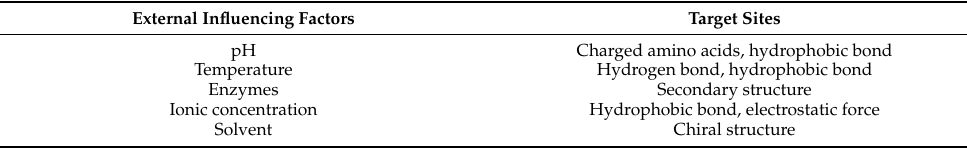
Table 1. Target sites of external factors on self-assembled